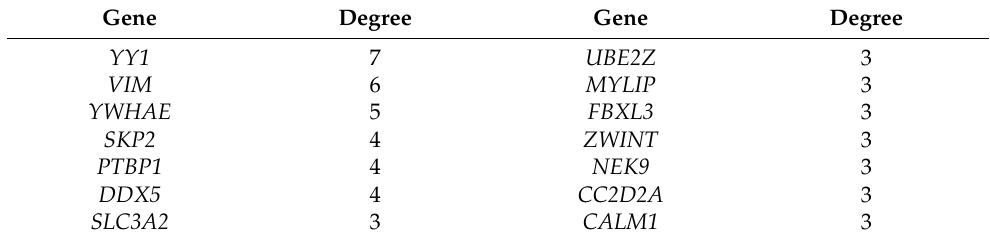
Table 5. The top 14 target genes and their degree of enrichment (5 candidate key miRNAs). Gene Degree Gene